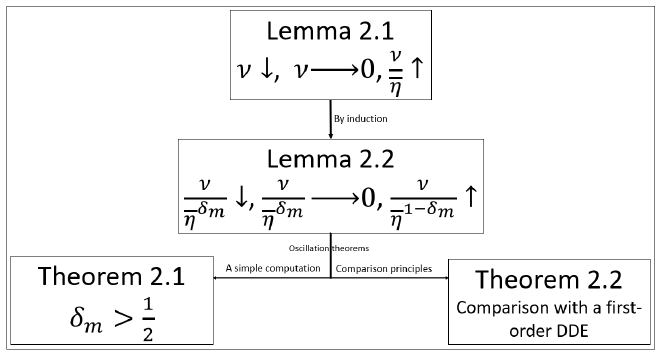
Figure 1. Schematic diagram for main